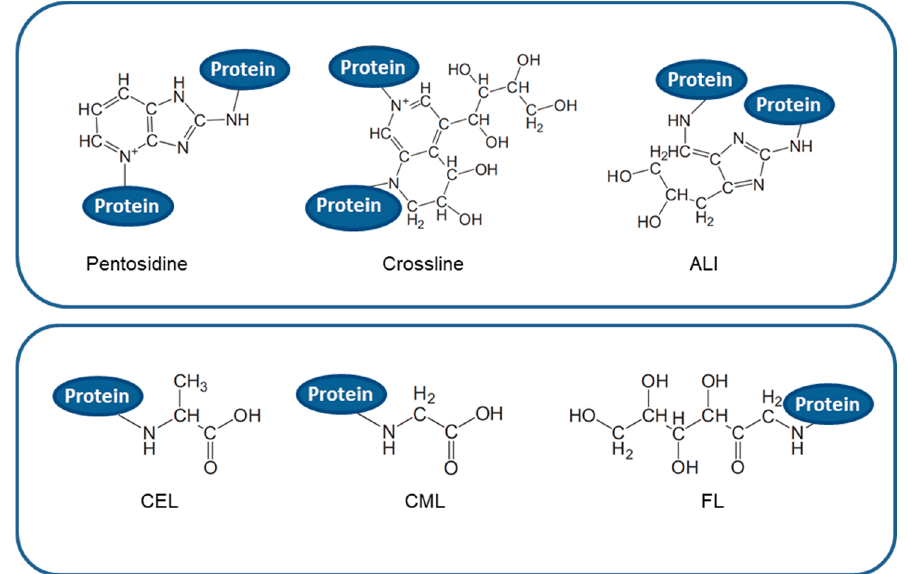
Figure 2. Chemical structure of different type of AGEs. Upper panel: cross-linking AGEs such as pentosidine; crossline; and ALI: arginine-lysine imidazole cross-links. Lower panel: non-cross-linking AGEs such as CEL: N-carboxyethyl-lysine; CML: N-carboxymethyllysine; and FL: N-fructosyl-lysine.